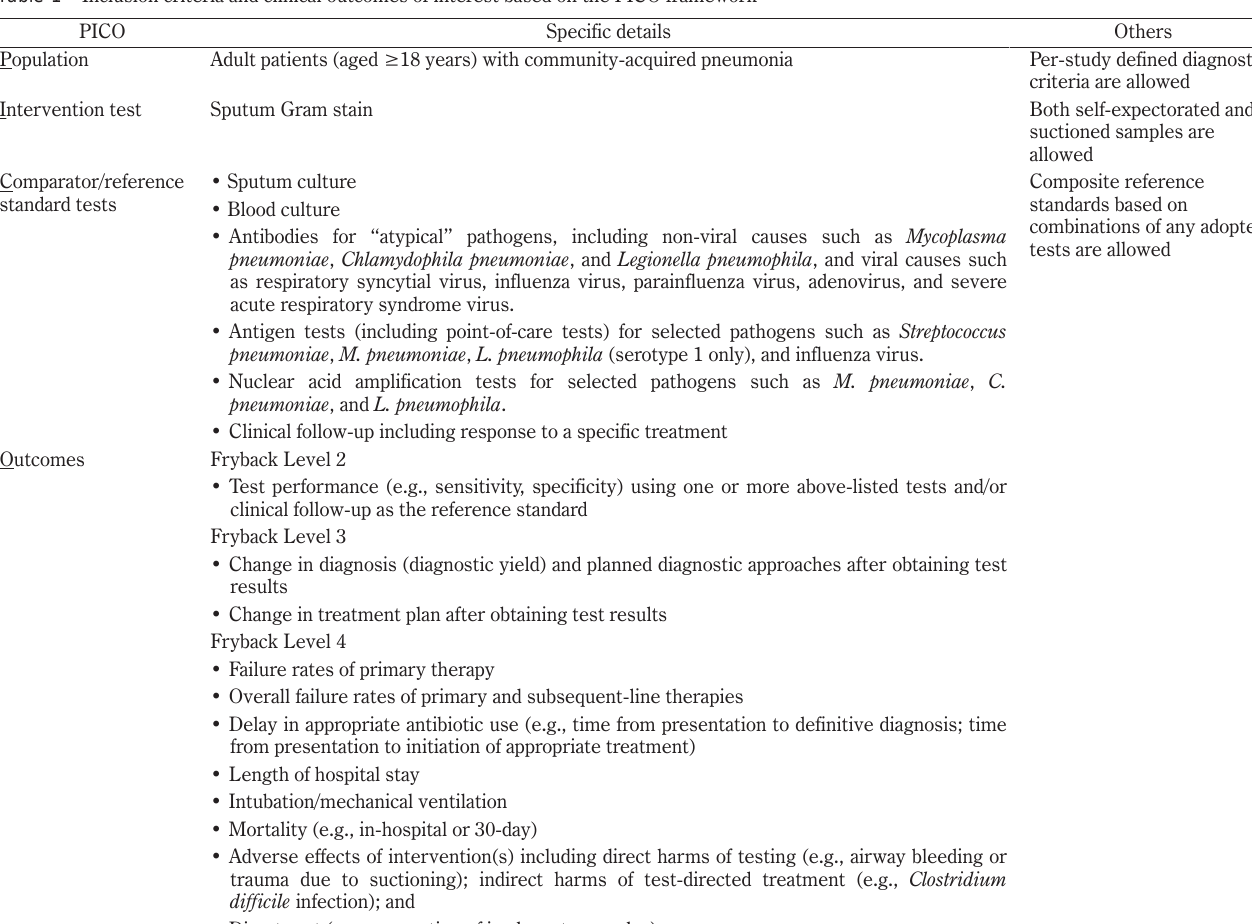
Table 1 Inclusion criteria and clinical outcomes of interest based on the PICO framework